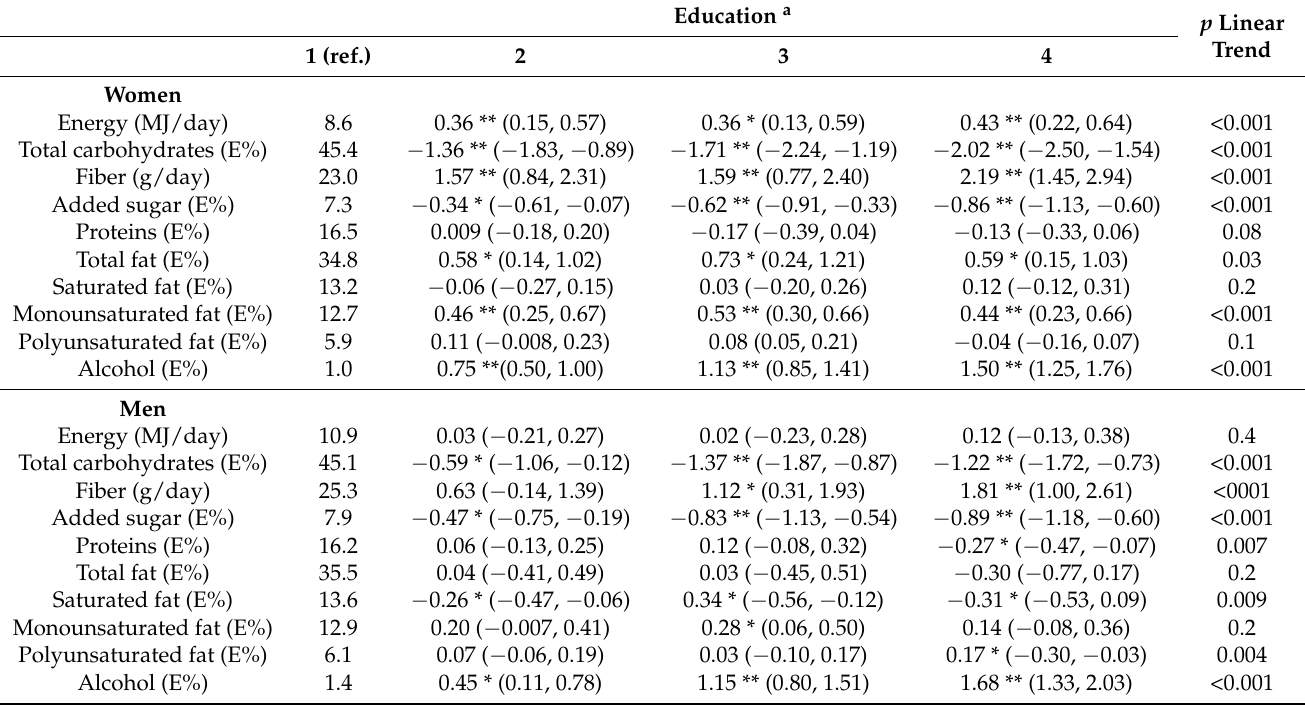
Table 3. Adjusted differences in energy and nutrient intakes by sex and education level. The Tromsø Study 2015–2016. Education a p Linear